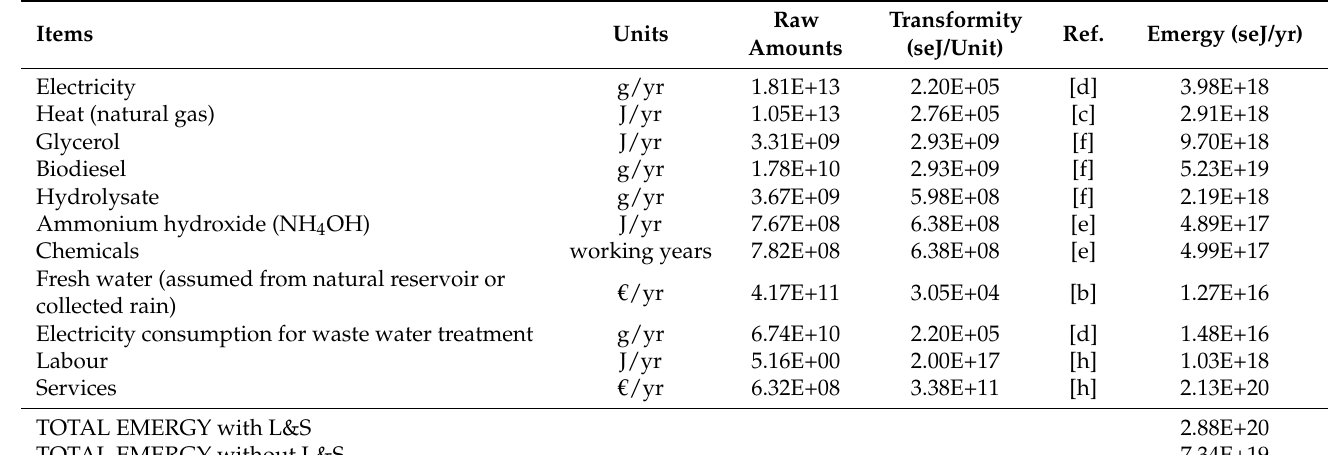
Table 7. Emergy table of fermentation (PHA production)